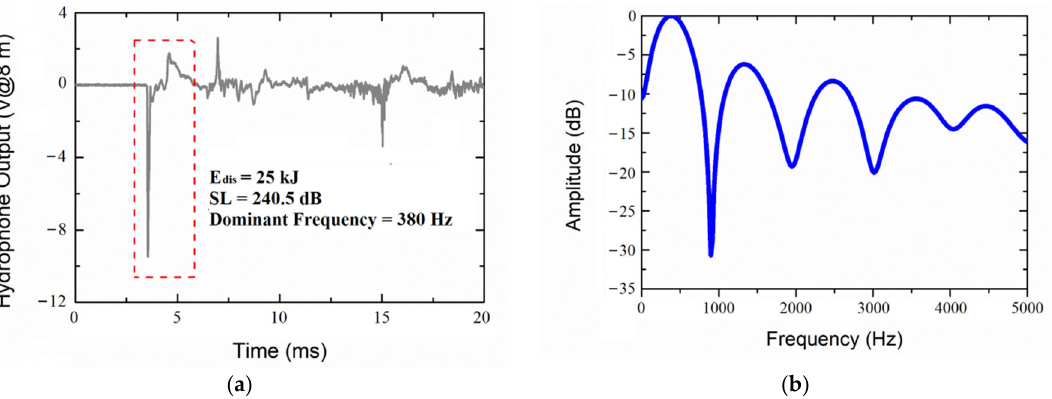
Figure 4. Results of the source wavelet test. ( a ) oscillogram of source wavelet; ( b ) frequency spectrum of source wavelet.